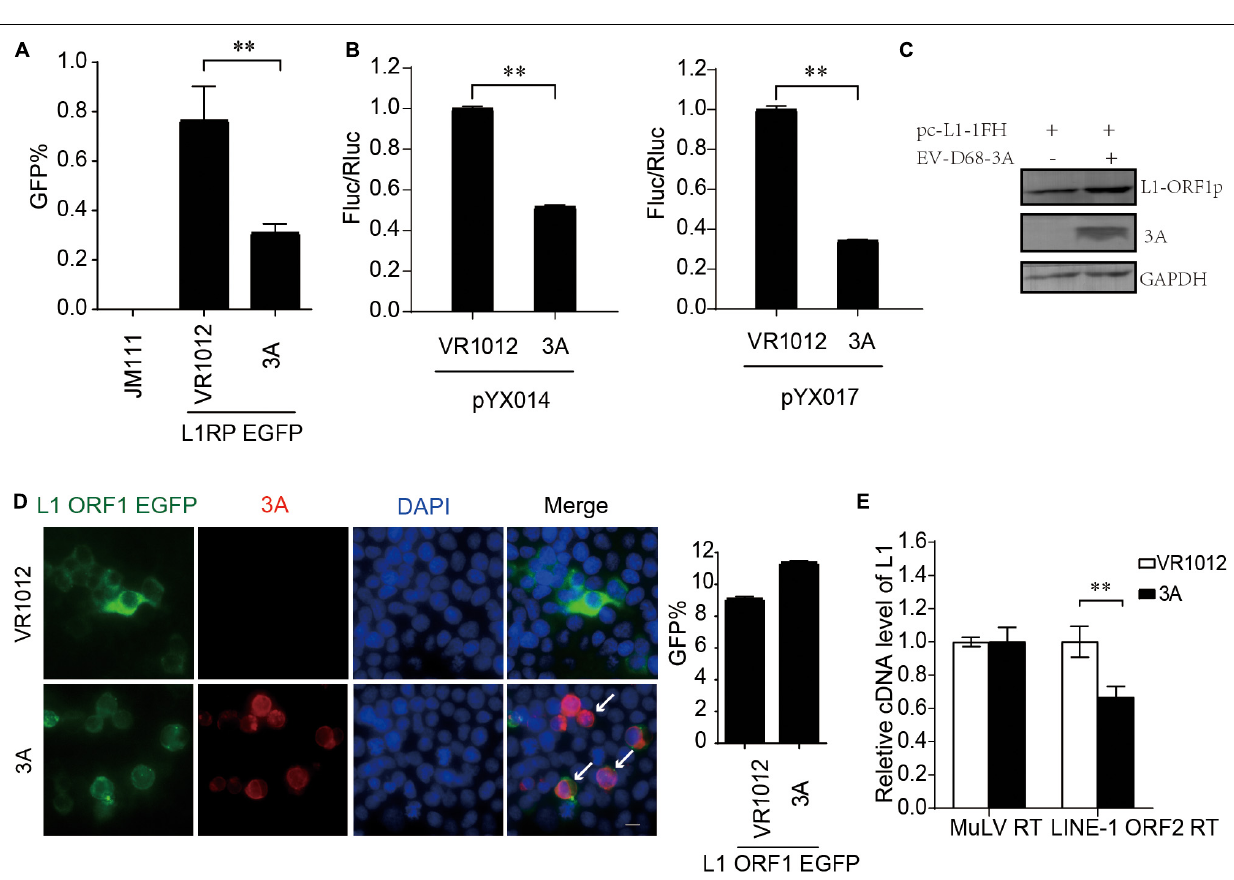
FIGURE 4 | Inhibition of LINE-1 retrotransposition by EV-D68 3A. (A) L1RP EGFP plasmids and VR1012/VR1012-3A plasmids were co-transfected into HEK 293T cells. JM111 was used as a negative control. Flow cytometry assay was performed 4 days post-transfection. The bar graph depicts the M ± SD of each experiment, performed in triplicate. The asterisks indicate statistically significant differences between groups by Unpaired Student’s t -test ( p < 0.01). (B) pYX014/pYX017 constructs and VR1012/VR1012-3A- plasmids were co-transfected into HEK 293T cells. Dual-Luciferase assay was performed 4 days after transfection. The VR1012-transfected group was set to 1.0. The asterisks indicate statistically significant differences between groups by Unpaired Student’s t -test ( p < 0.01). (C) VR1012 or VR1012-3A plasmids were co-transfected with pc-L1-1FH. Immunoblot was performed on cell lysate after 48 h. (D) HEK293T cells were transfected with pEGFP-N1-ORF1-EGFP and VR1012/VR1012-3A plasmids. Immunostaining and fluorescence imaging were performed as described in the “Materials and Methods” after 48 h: scale bar, 20 µ m. Bar graph represents the percentage of GFP-positive cells from flowcytometry. The asterisks indicate statistically significant differences between groups by Unpaired Student’s t -test ( p < 0.01). (E) LEAP assay and quantitative real-time PCR were performed as described in the “Materials and Methods.” The bar graph of relative cDNA level of L1 represents reverse transcription efficiency of L1 ORF2p or MuLV. The relative cDNA level of MuLV RT was set to 1.0. The asterisks indicate statistically significant differences between groups by Unpaired Student’s t -test ( p <